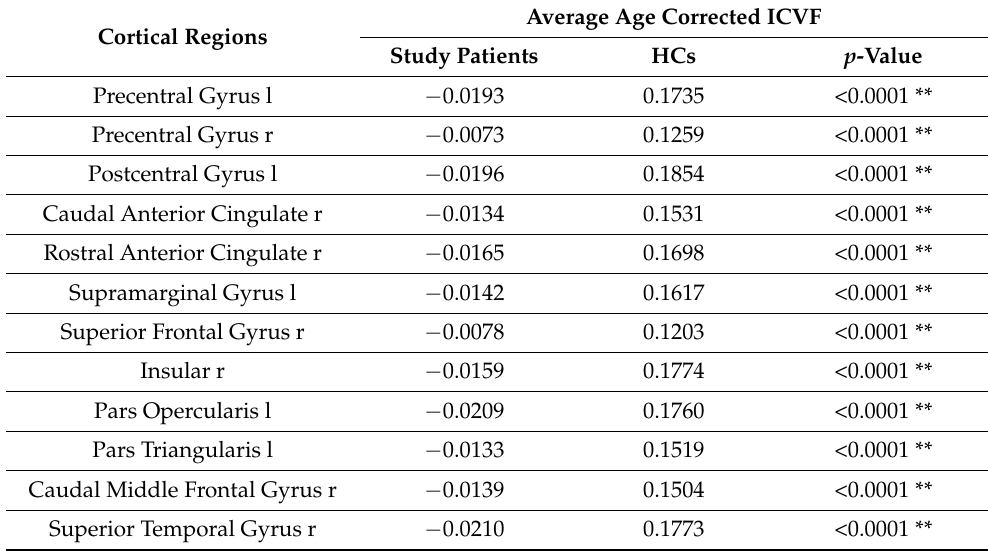
Table 2. Thinning Cortical Regions Showing Differences in ICVF Values between Study Patients and HCs.